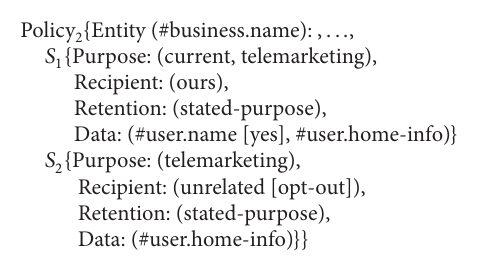
Algorithm4:P3Pprivacypoliciesofthreesingleservices(Policy